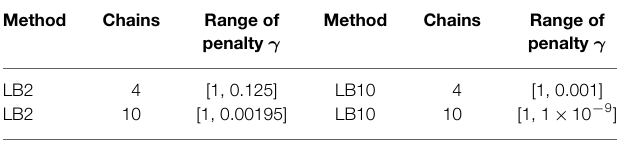
TABLE 1 | Ranges of the penalty parameter (cid:13) i for LB2 and LB10 . Method Chains Range of penalty (cid:13)